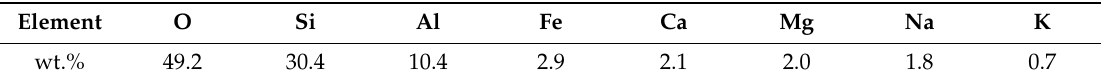
Table 2. Chemical composition of bentonite in wt.%.